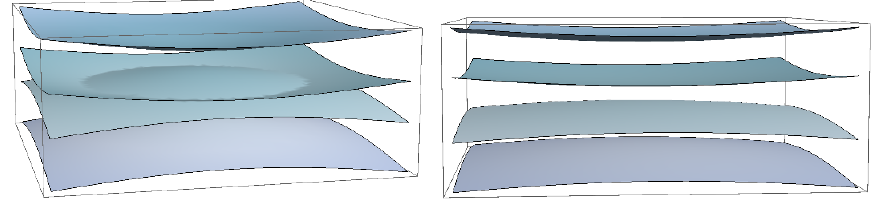
Figure 1 . The energy spectrum as a function of k x ; k y for k z = 0. Left: there is a nodal line at the band crossing when m 2 < 4 b 2